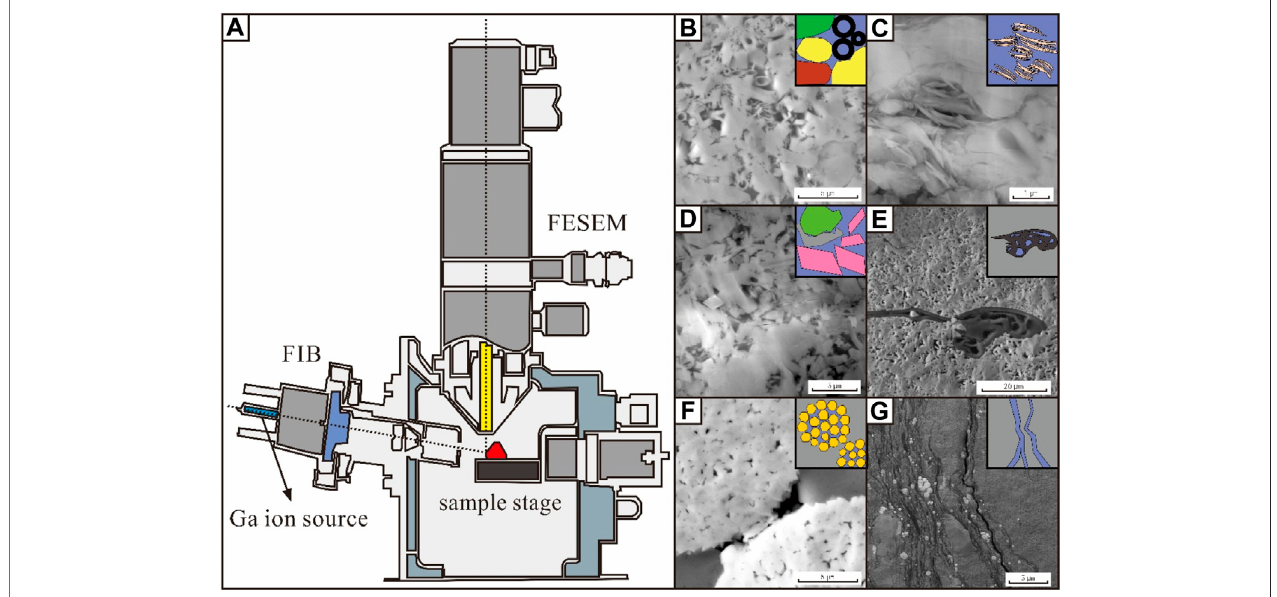
FIGURE 5 | Focused ion beam – scanning electron microscopy (FIB-SEM) structure and the image of shale pore structure: (A) Structure of FIB-SEM; (B) Intergranular pores and fossil pores; (C) Pores between clay platelets; (D) Pores between crystals and pores at the edge of rigid grains; (E) Organic matter pores; (F) Intercrystalline pores within pyrite framboids; and (G) Fracture pores (Anderson, 2014).